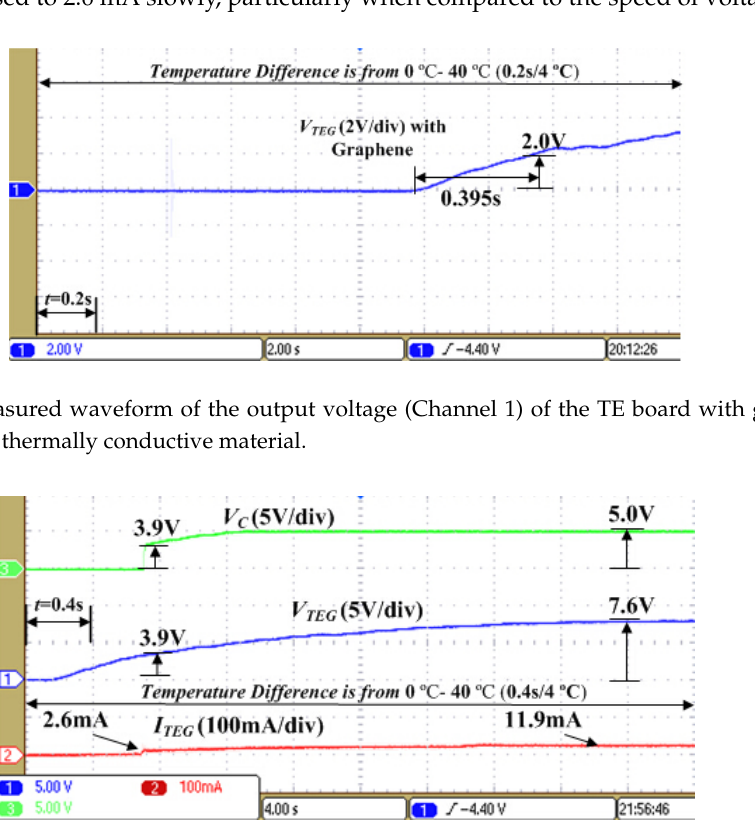
Figure 14. Channel 1 is output voltage, Channel 2 is output current, and Channel 3 is constant output voltage of buck converter for supercapacitor is 5.0 V.